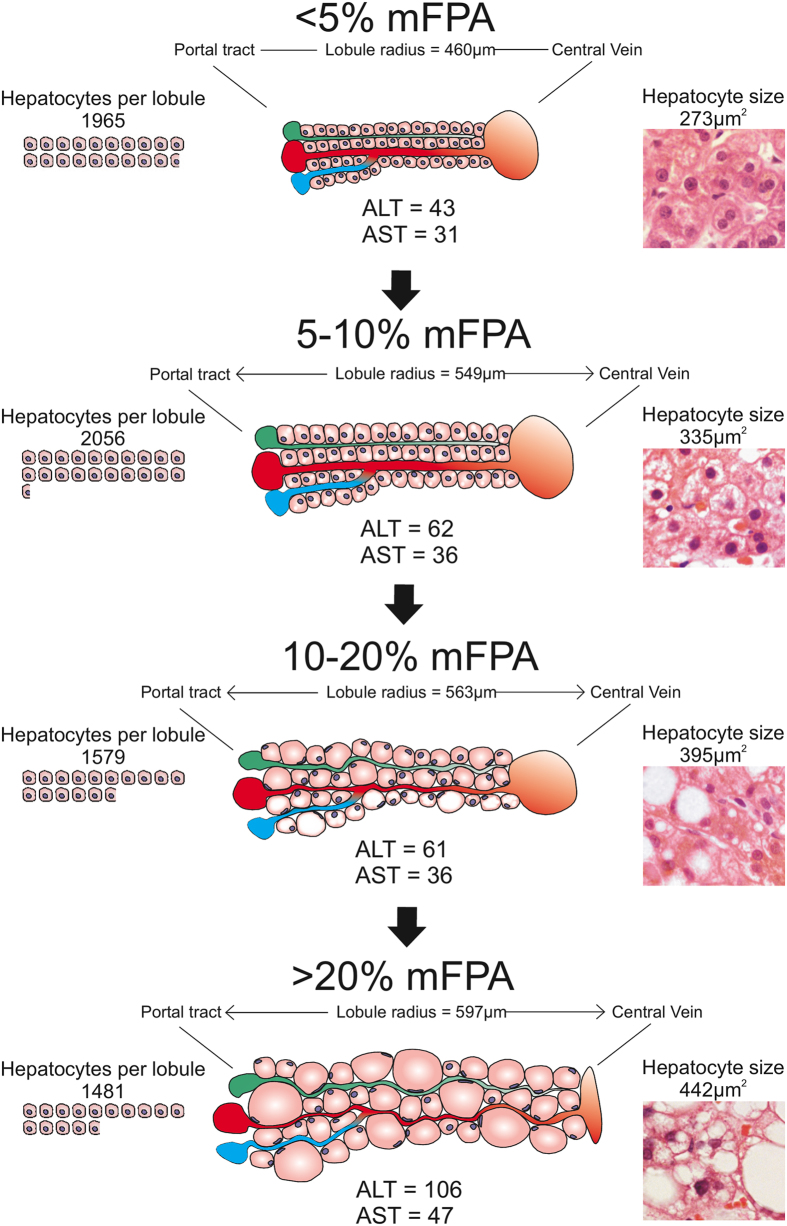
Diagrammatic representations of the changes in the lobule with increasing fat content.As the liver accumulates fat in the hepatocytes (5–10% mFPA) they swell in size and the lobule initially similarly expands. The number of hepatocytes in the lobule remains consistent but there is a significant rise in both ALT and AST. As the hepatocytes accumulate more fat (10–20% mFPA) the lobule does not significantly increase in size but there is a corresponding reduction in the number of hepatocytes. Further accumulation of fat by the liver (>20% mFPA) produces even larger hepatocytes and a further incremental increase in ALT and AST. The cases with >20% mFPA showed architectural disorganization at the lobular level with a notably compressed central vein often causing difficulties in identifying it on H&E.